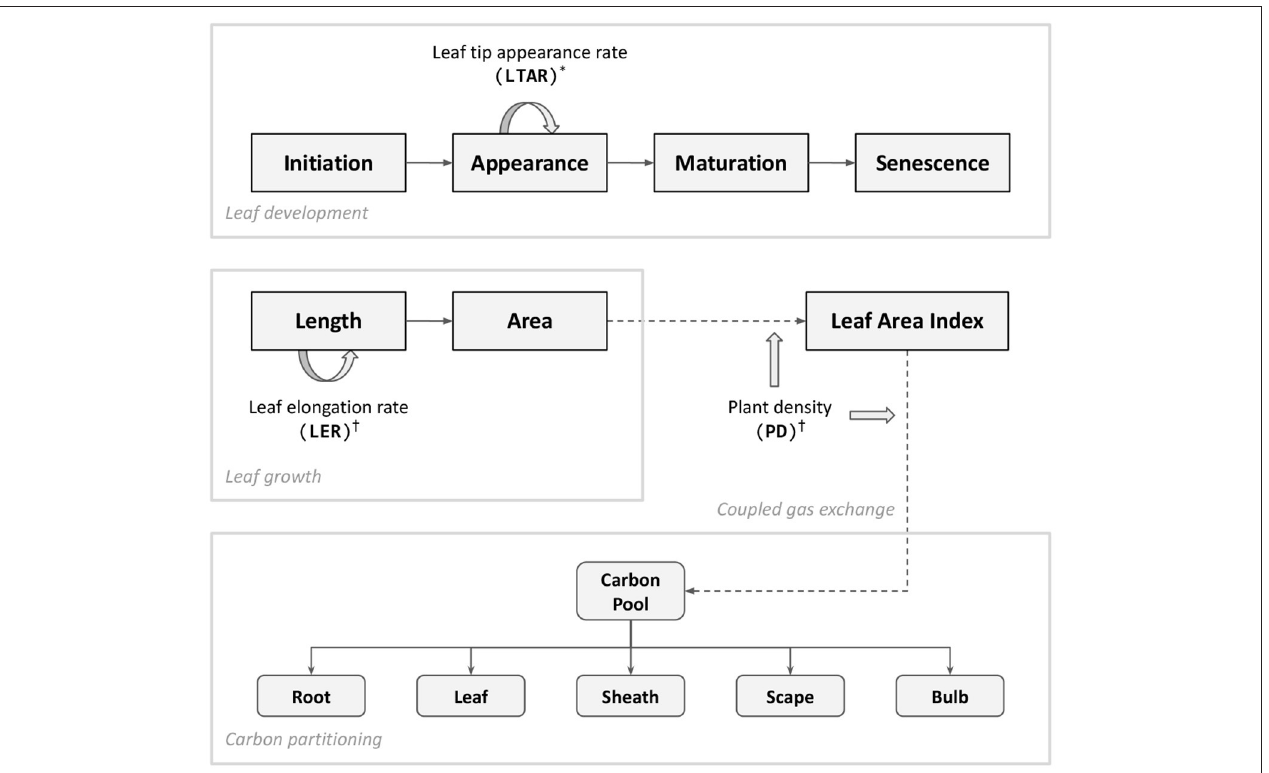
FIGURE 1 | Diagram of key processes updated in the model presented in this paper. Leaf appearance is driven by an accumulation of leaf tip appearance rate (LTAR) which is modified according to dynamic phyllochron (*). Cold stress ( † ) is implemented in two folds; individual leaf-level growth driven by leaf elongation rate (LER) and plant population-level response accounted by plant density (PD). Carbon assimilated through coupled gas exchange forms a carbon pool which determines the amount of carbon partitioned into individual organs. The bulb carbon constitutes a final yield of garlic. For a complete structure of the model, refer to Figure 1 of Hsiao et al.